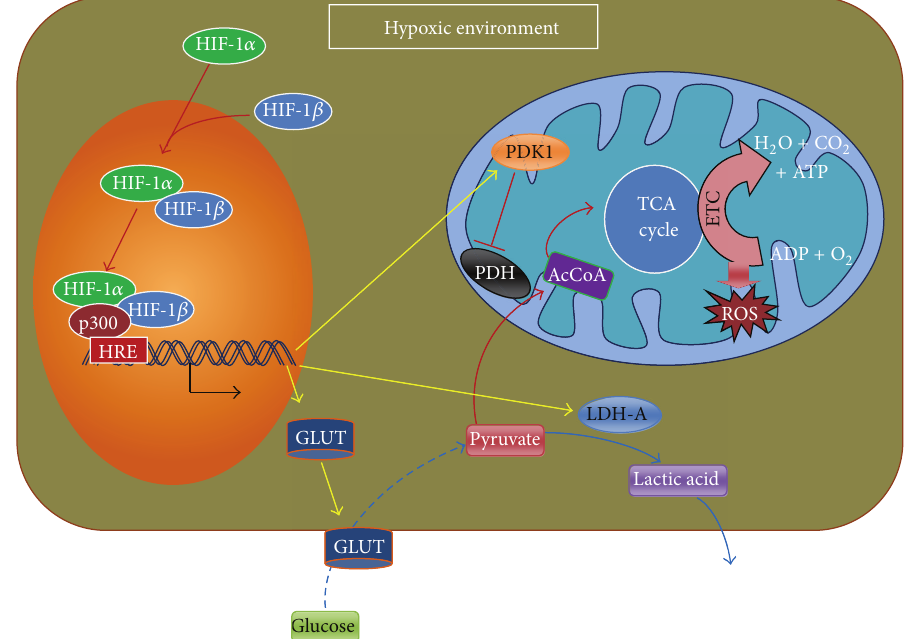
Figure 3: Suppression of mitochondrial respiration by HIF-1 𝛼 in hypoxic environment. HIF: hypoxia-inducible factor; HRE: hypoxia- response element: GLUT: glucose transporter; LDH: Lactate dehydrogenase; PDH: pyruvate dehydrogenase; PDK: pyruvate dehydrogenase kinase; TCA: tricarboxylic acid; ETC: electron transport chain; ROS: reactive oxygen species (see text for